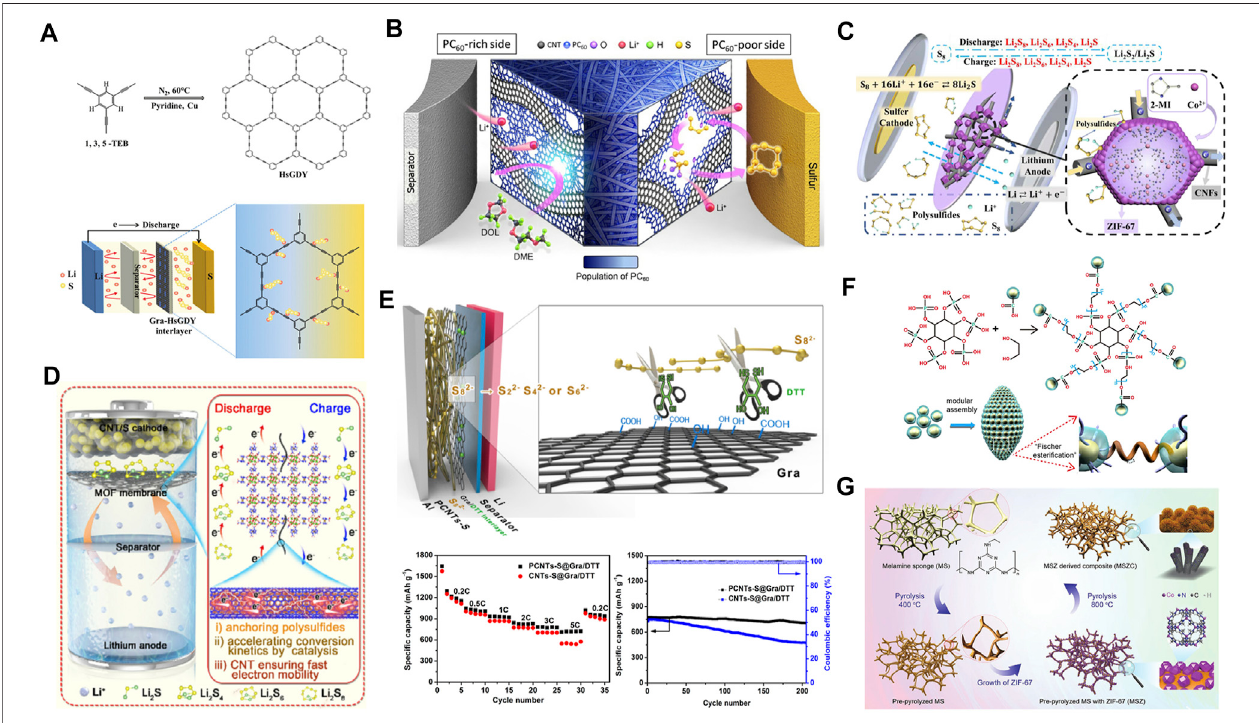
FIGURE 4 | The strategy and performance of organic electrocatalysts for Li − S interlayers. (A) Schematic illustration of a Gra-HsGDY interlayer. (A) Figure reproduced from the data in Kong et al. (2021). (B) The illustration of dual functional and population gradient CNT@PC 60 interlayer in Li − S batteries. (B) Figure reproducedfromthedatainHuetal.(2020). (C) MechanismofphysicalbarrierandchemicaladsorptionforLiPSsbytheZIF/CNFsinterlayer. (C) Figurereproducedfrom the data in Li J. et al. (2021). (D) The con fi guration and reaction mechanisms of bimetallic Zr − Fc MOF/CNT interlayer in Li − S batteries. (D) Figure reproduced from thedatainWangY.etal.(2021). (E) Schematiccon fi gurationofGra/DTTinterlayeranditselectrochemicalperformance. (E) FigurereproducedfromthedatainHuaetal. (2017). (F) The modularly assembled XC72 carbon black nanoparticles for the MAXC interlayer. (F) Figure reproduced from the data in Ye et al. (2017). (G) Typical synthetic process of freestanding MSZC for Li − S interlayers. (G) Figure reproduced from the data in Qian et al. (2020).